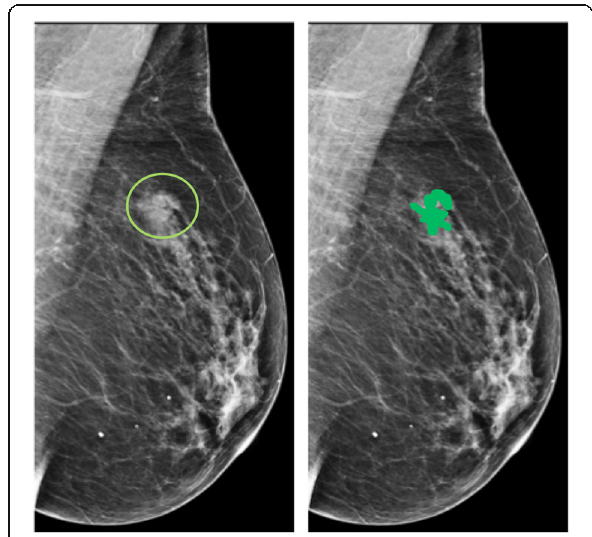
Fig. 1 Medio-lateral oblique view (two-dimensional image). On the left, the circle highlights the suspicious spiculated lesion. On the right, the region of interest (coloured in green) defined by the reader. The region of interest was then transferred to the central tomo slices using a software and adjusted if necessary